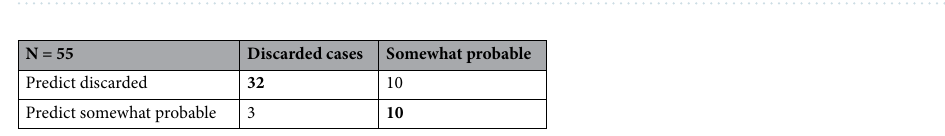
Table 2. Evaluation for the best model in untrained data (test data) for each group. Group 1 is made up of patients without text data, and Group 2 patients with text data.